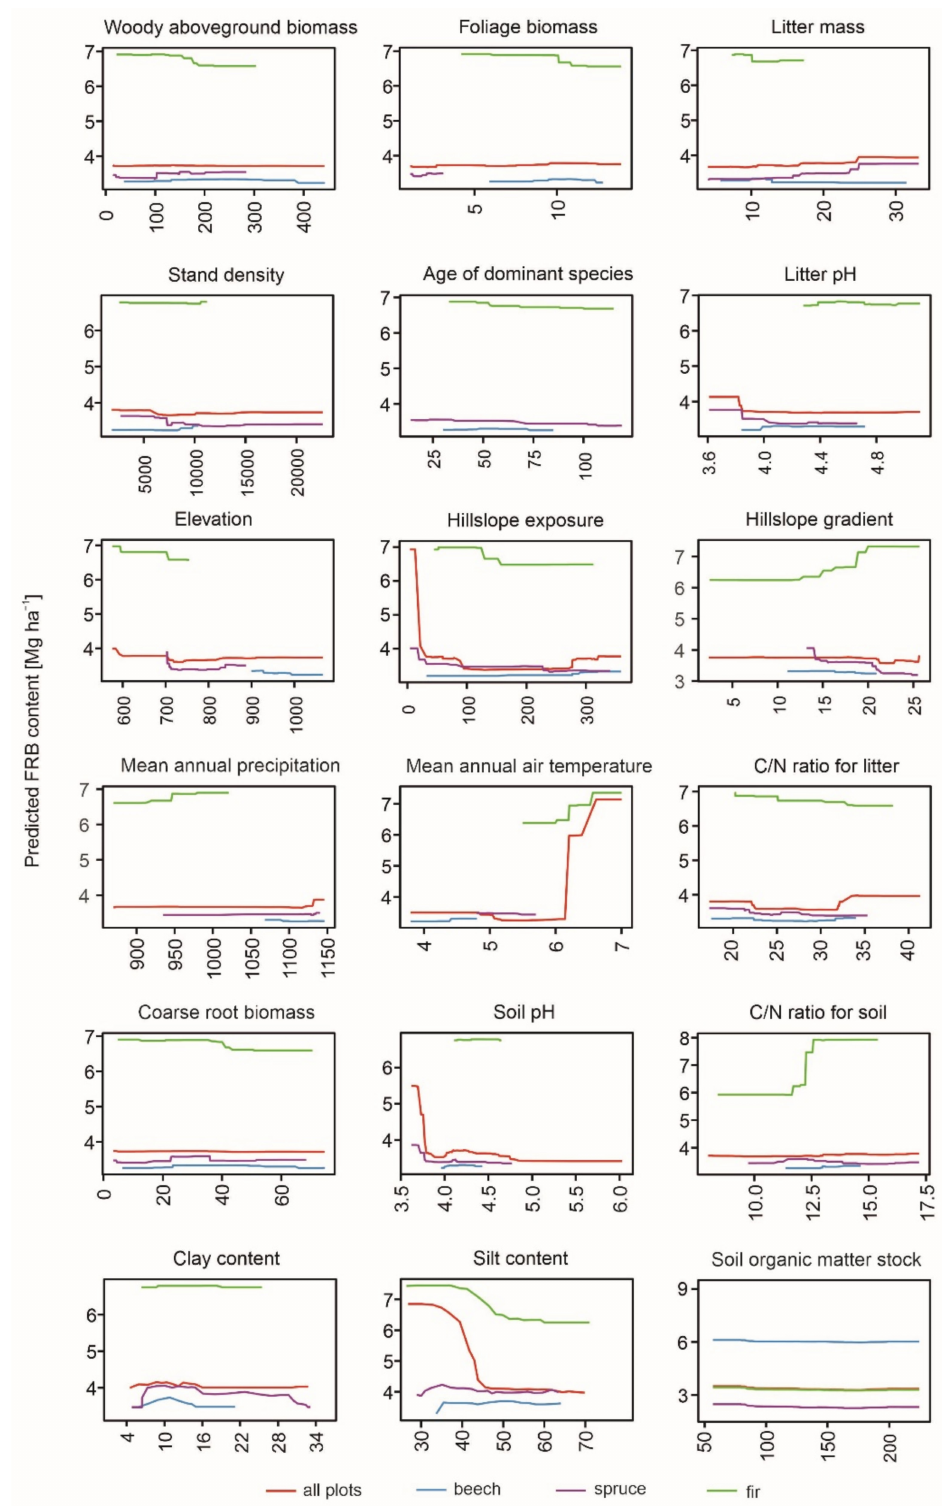
Figure 8. Partial dependence plots (pdp) showing average predictions of FRB content. Lines show average predictions for continuous predictors, assuming mean values of all remaining predictors. Abbreviations—see explanation in Table 2. Explanation of interpretation of pdp included in Section